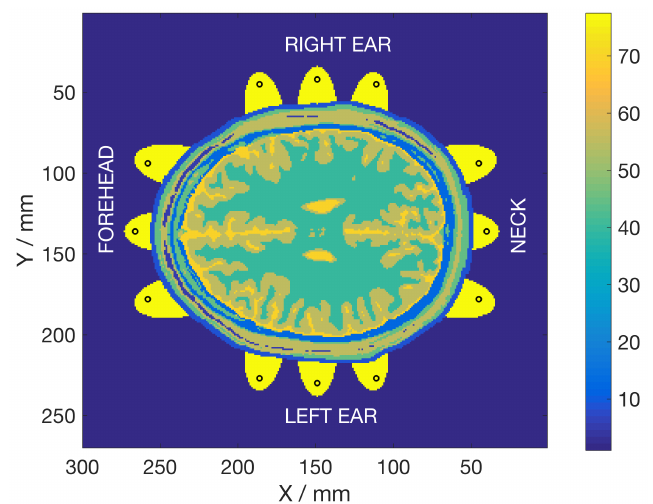
Figure 3. Cross-section of the head at the center of the vertical antennas. The figure shows the relative static permittivity, (cid:101) static , in the Debye model. Antenna positions are marked with black circles and the immersion medium as elliptically-shaped cylinders. The color bar shows relative permittivity.